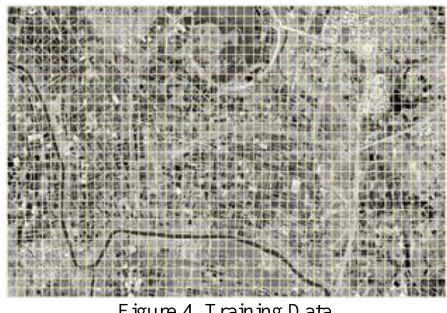
Figure 4. Training Data